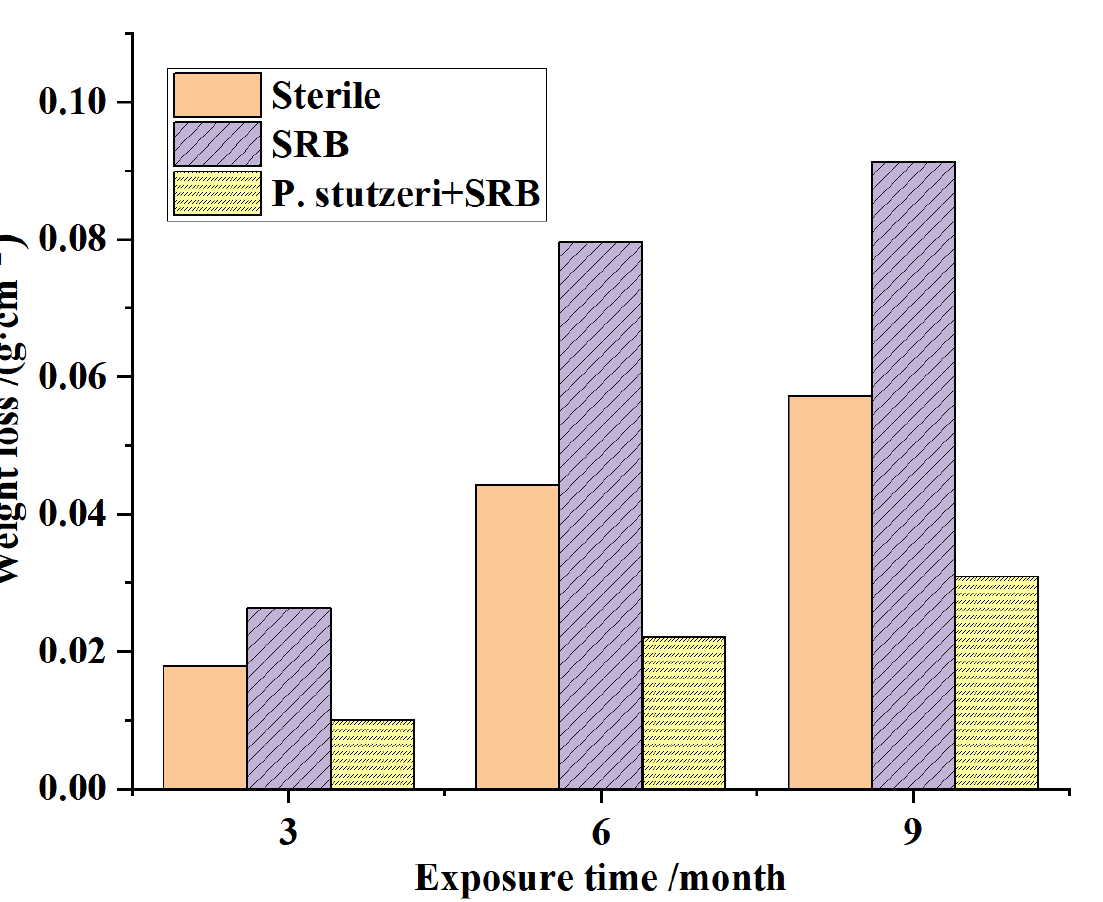
Figure 10a,b are the corrosion polarization curves for SRB and SRB + P. stutzeri samples,